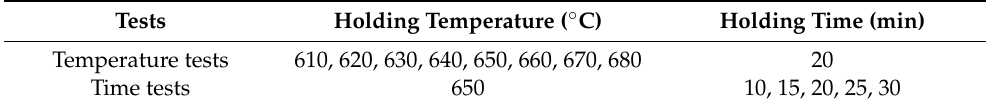
Figure 2. Semi-solid direct-writing forming equipment diagram. Table 2. Process test parameters. Table 2. Process test parameters.